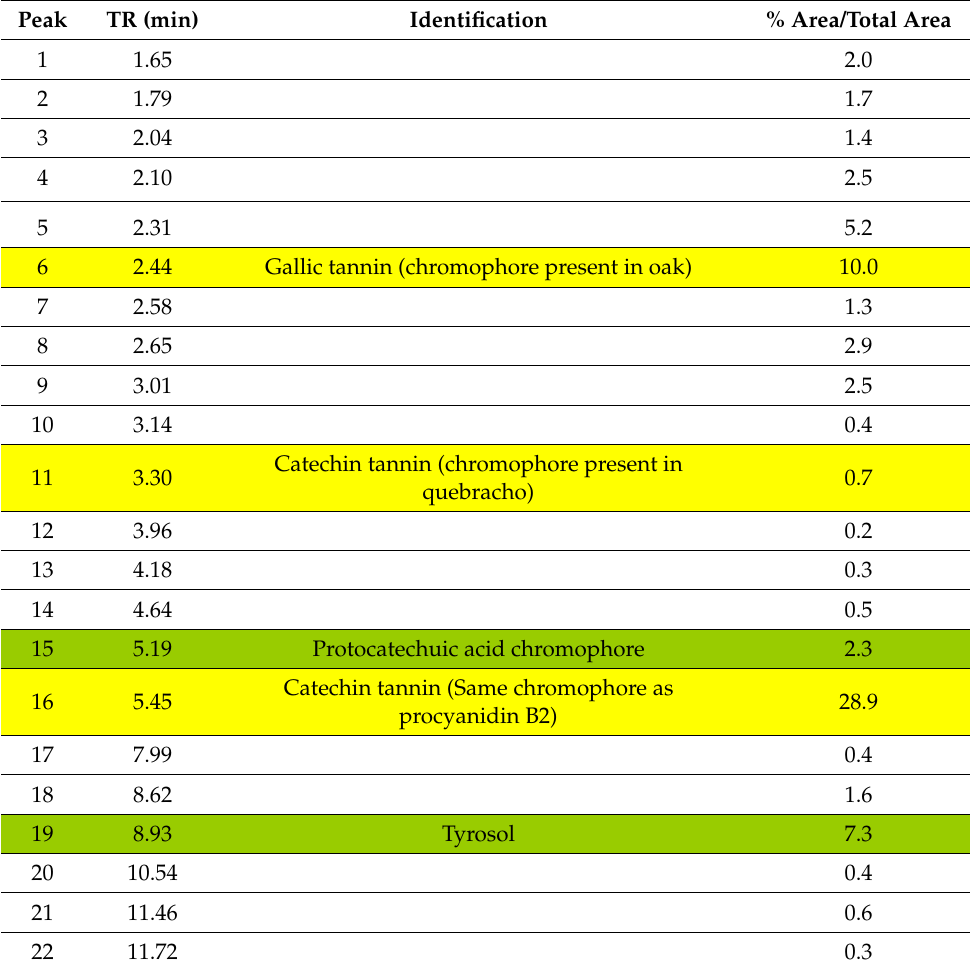
Figure 4. Olive pulp chromatogram. Table 5. Identification of polyphenolic compounds in the olive pulp.